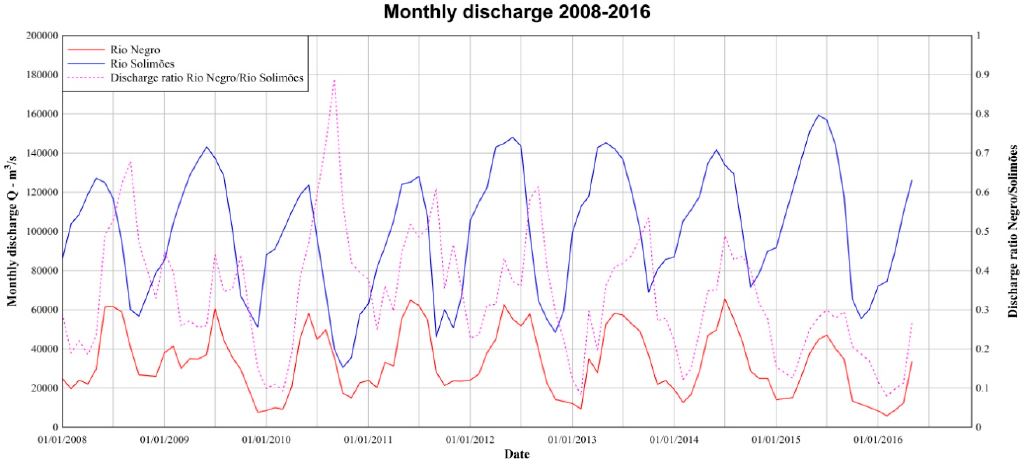
Figure 3. Discharge time series from 2008 to 2016.